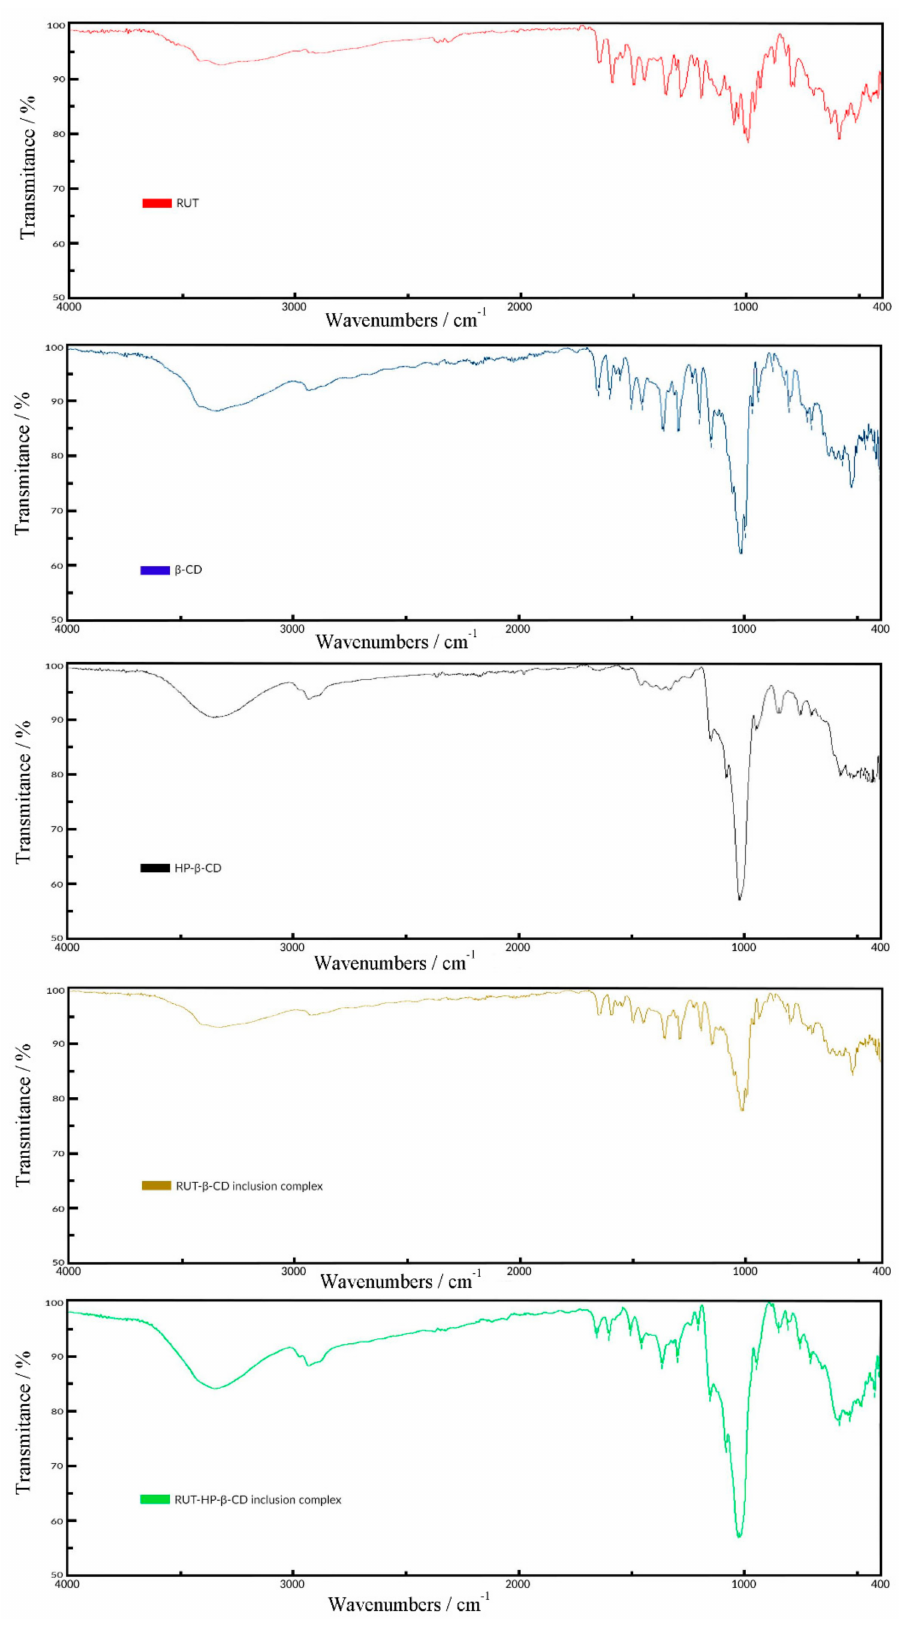
Figure 3. FT-IR spectra of RUT (red line), β -CD (blue line), HP- β -CD (black line), and the inclusion complexes: RUT- β -CD (olive line) and RUT-HP- β -CD (green